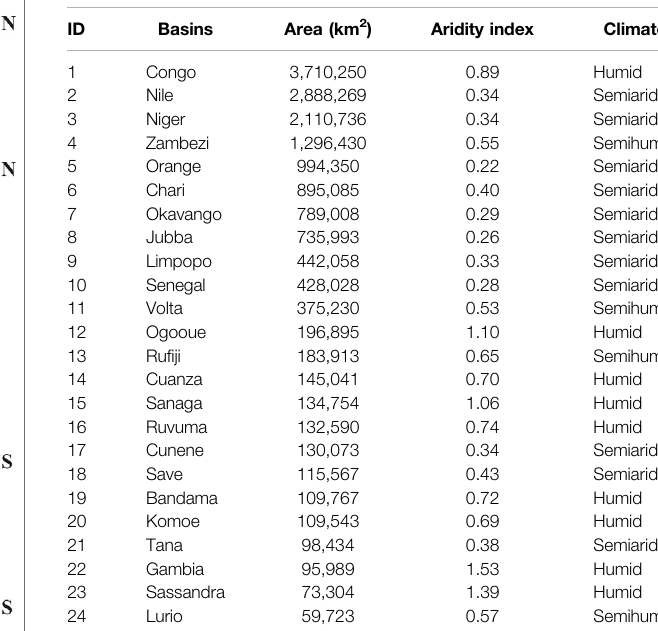
TABLE 1 | Characteristics of the river basins over Africa.